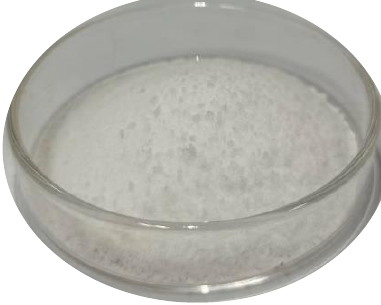
Figure 6. Picture of sodium